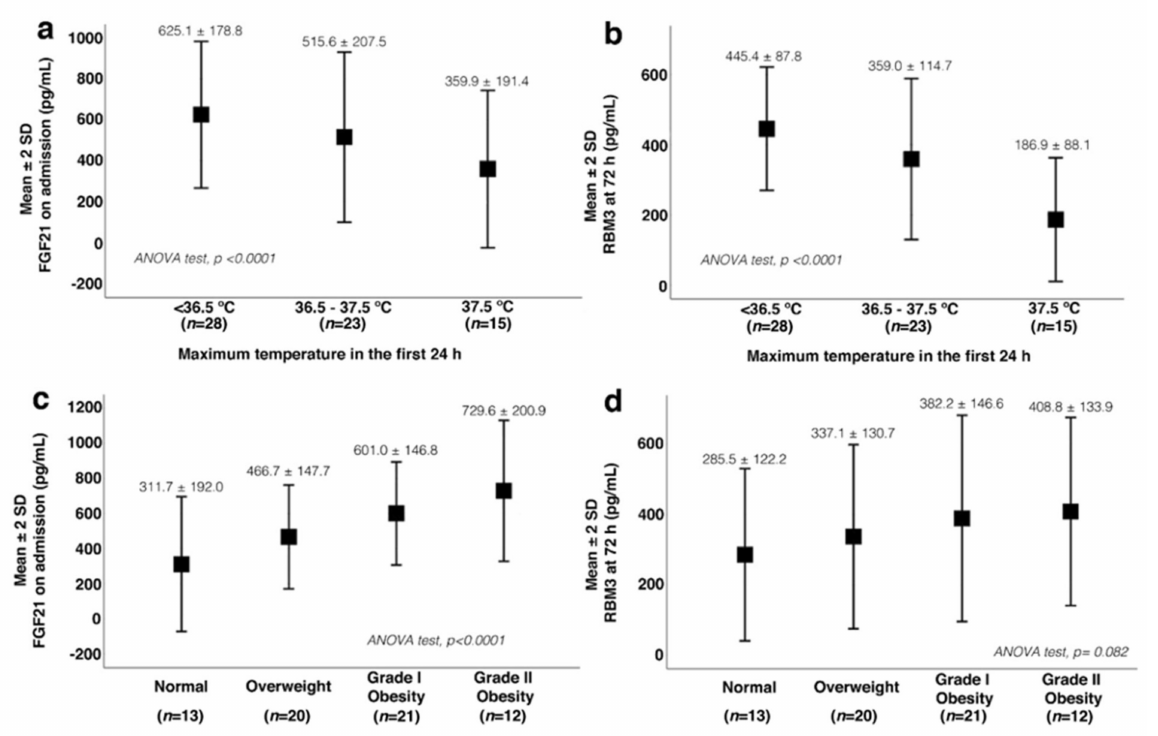
Figure 3. Analysis of serum fibroblast growth factor 21 (FGF21) and RNA-binding motif protein 3 (RBM3) and their association with temperature ( a , b ) and body mass index (BMI) ( c , d